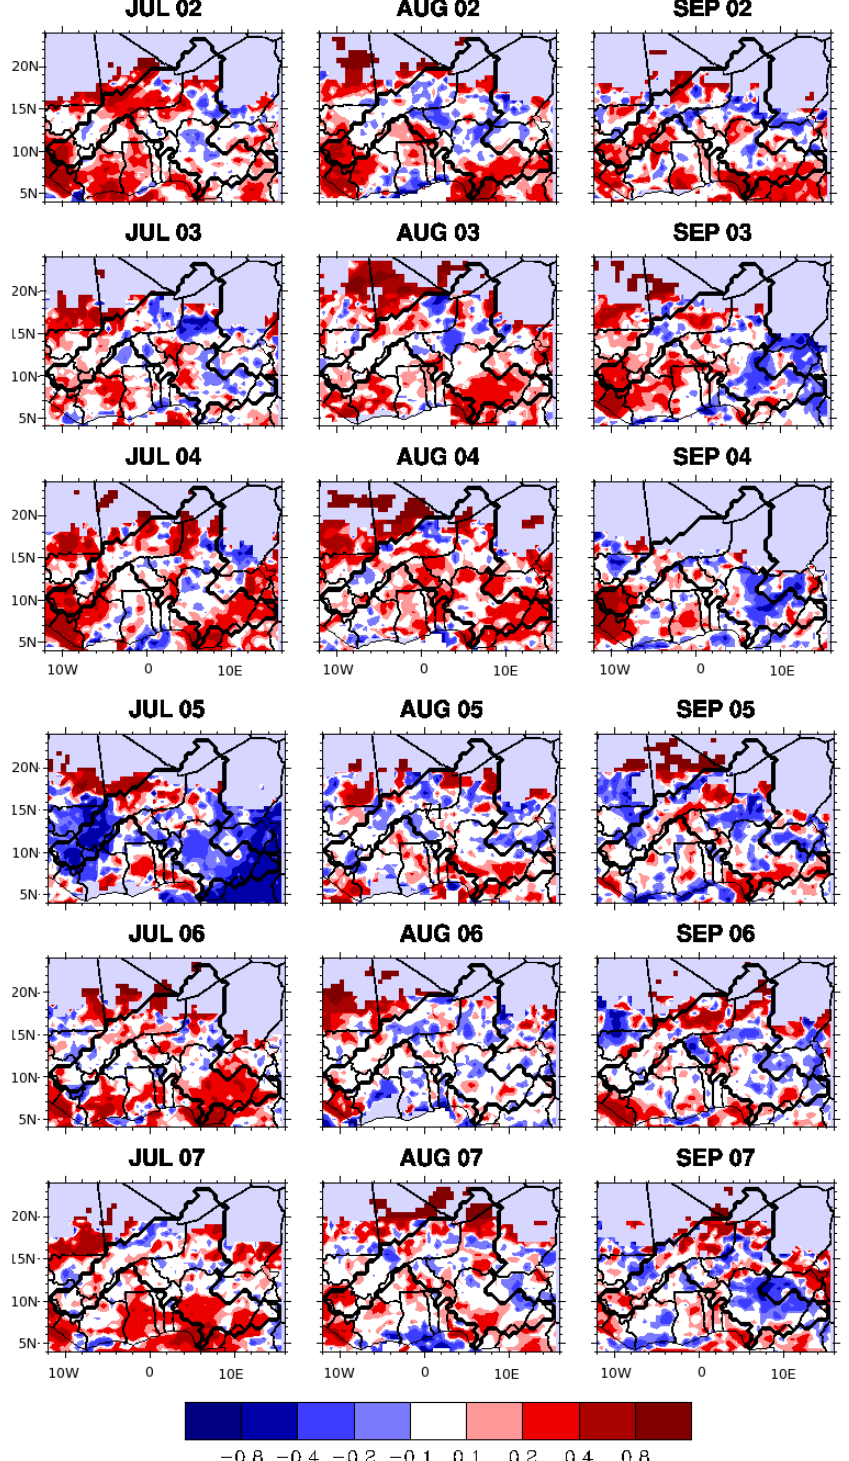
Fig. 13. Rainfall monthly averaged ratio (TRMM-RFEH)/(TRMM+RFEH). The ratio is calculated only when the sum TRMM+RFEH is bigger than 1mm/day.